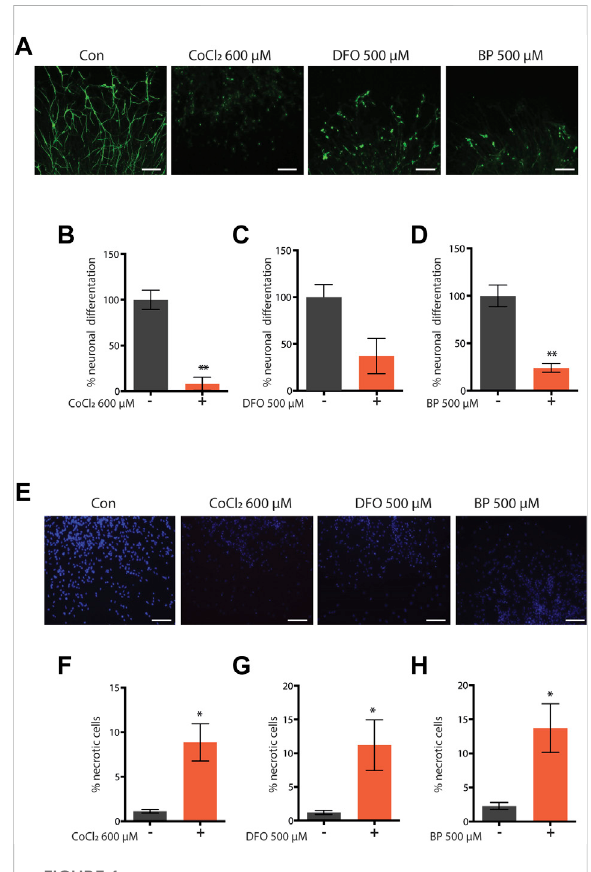
FIGURE 1 (A – H) Representative pictures and quanti fi cation of neuronal differentiation (A – D) and necrotic cell death (E – H) of mouse embryo iPS-derived neurospheres left untreated or treated with cobalt chloride 600 µM (CoCl — 600 μ M) (A – F) for 48 h, deferoxamine 500 µM (DFO 500 μ M) (C,G) for 72 h, or 2,2 ′ - dipyridyl 500 µM (BP 500 μ M) (D,F) for 72 h during neuronal precursor cells (NPC) differentiation. Bar graph represents means ± SEM from n = 3 independent replicas where N = 5 randomly chosen fi elds were scored. Unpaired t-test, * p value < 0.05 and ** p value < 0.01 versus untreated. Above the bar graphs are shown the representative fl uorescence pictures of the corresponding conditions. Scale bar are 100 µm. Green fl uorescence pictures show neurons stained with beta-III-tubulin (A) , and blue fl uorescence pictures show nuclei stained with Hoechst 33342 (E)